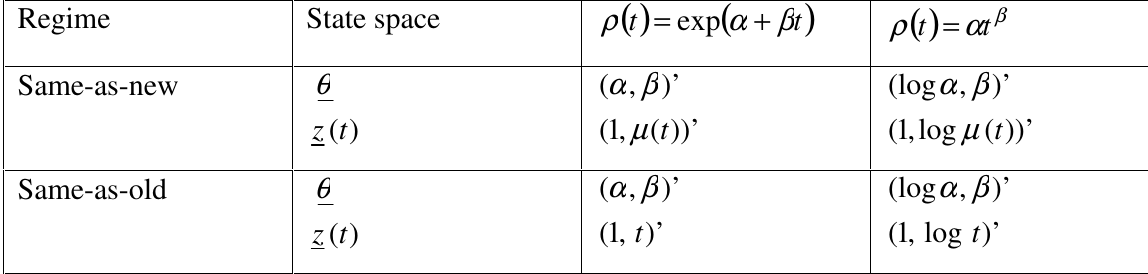
Table 2: State Space for Cox & Lewis and Power